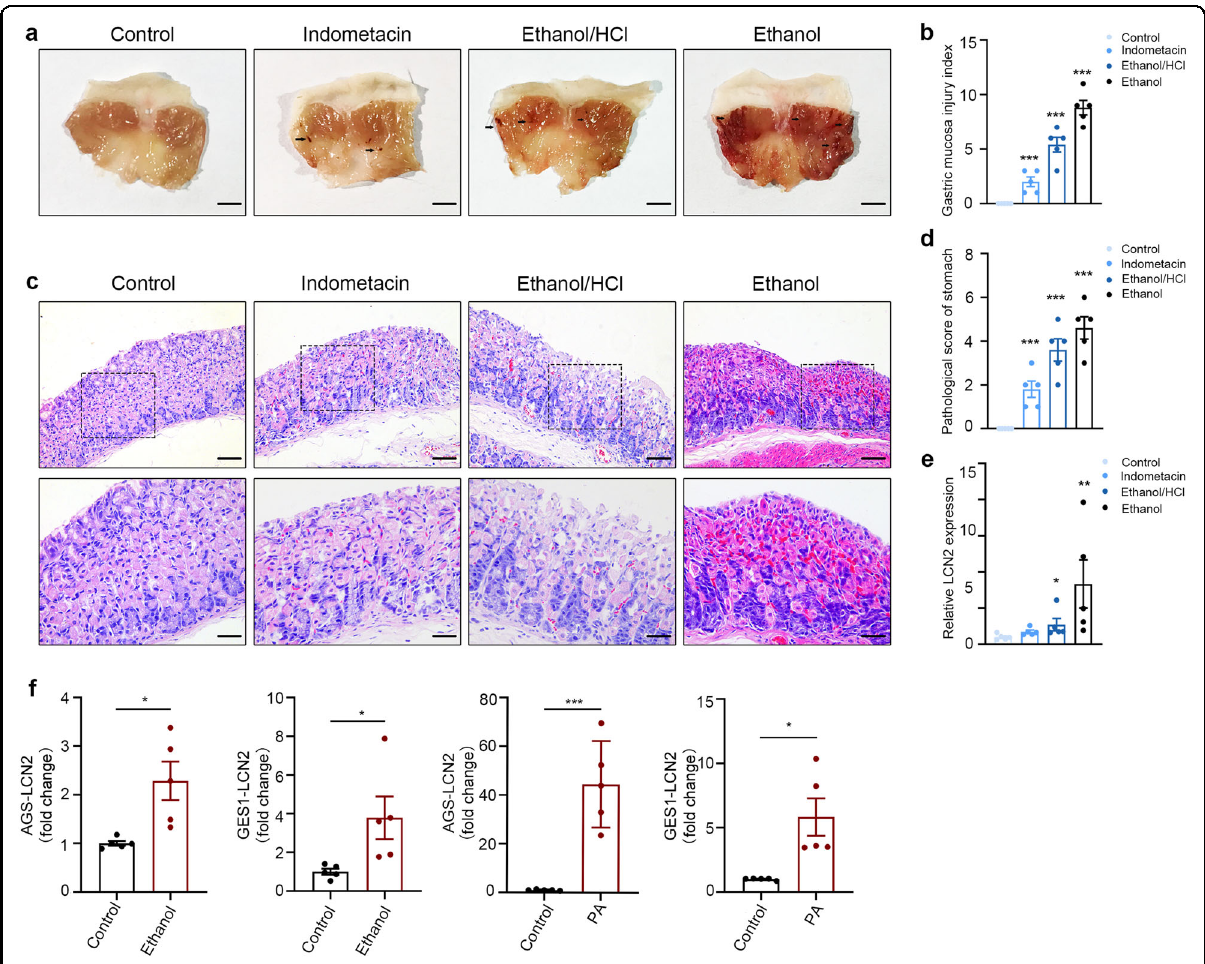
Fig. 3 Gastric mucosal injury leads to LCN2 over-expression. a Indometacin, acidi fi ed ethanol and ethanol induced gastric injured model on the macroscopic properties. Arrows indicate the damage (linear hemorrhages, mucosal erythema and hemorrhagic ulcers) on gastric mucosa. b Gastric mucosa injured index of the control, indomethacin, ethanol/HCL and ethanol groups. c HE-stained gastric mucosal tissues of mice in four groups (magni fi cation, ×100 and ×200; 100 µm scale bar). d The degree of pathological damage in stomach using Masuda criteria. e Quanti fi cation of LCN2 expression in these four groups. f The expression of LCN2 in AGS and GES1 cells simulated with alcohol and palmitic acid. The data are expressed as the mean ± s.e.m. ( n = 5) * P < 0.05, ** P < 0.01, *** P < 0.005 compared to the control